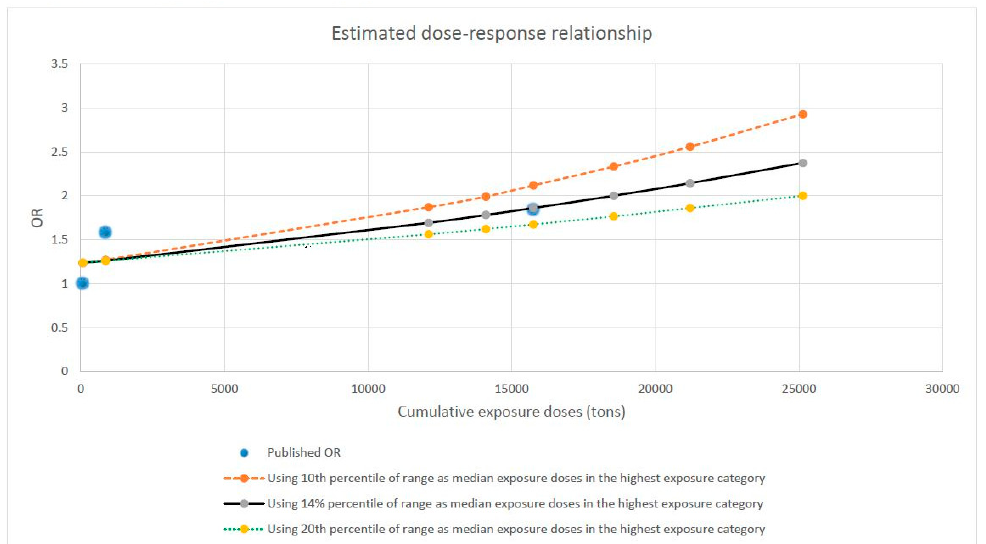
Figure 4. Extrapolated course of the dose–response relationship between heavy lifting and the risk of hip osteoarthritis based on findings published by Vingard et al. 1991 [13].